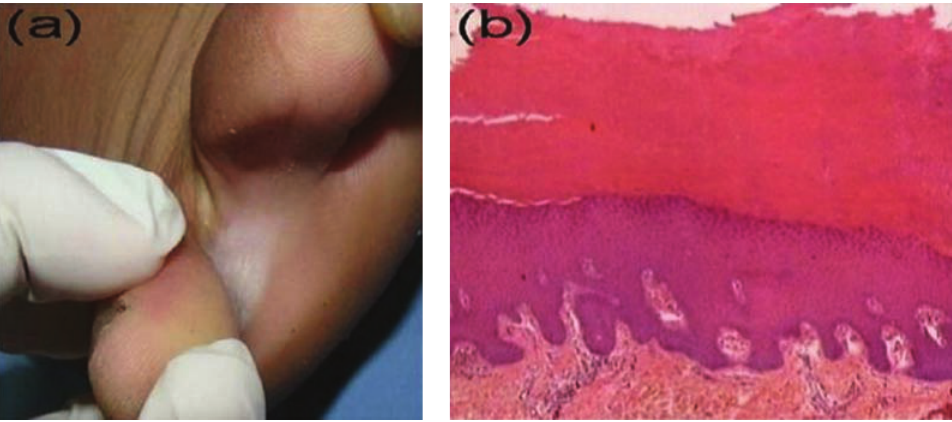
Figure 3: Interdigital callosity. (a) Interdigital whitish plaque with well-defined border. (b) Histopathological picture showing compact hyperkeratosis and moderate acanthosis (H&E, ×